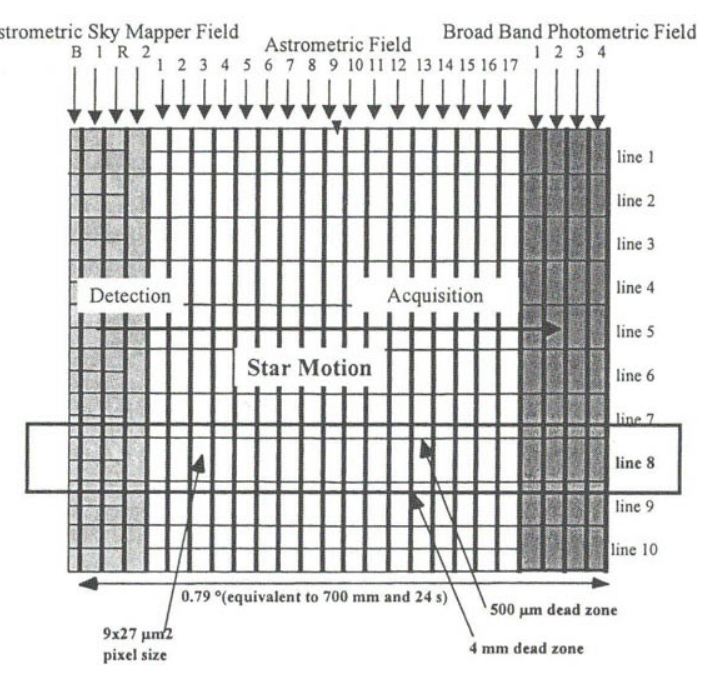
Fig. 6. Gaia astrometric focal